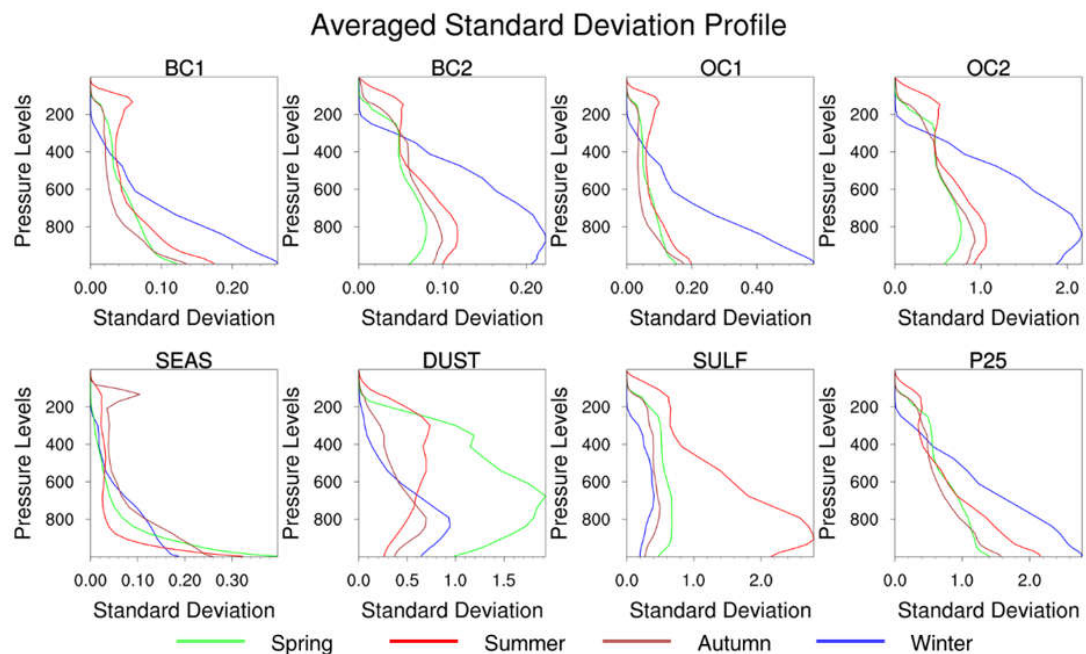
Figure 3. Vertical distributions of the standard deviation of the model background error for 8 GOCART aerosol species averaged over Domain 2 in winter (blue), spring (green), summer (red), and autumn (brown). Values in four different-sized bins are averaged for dust and sea